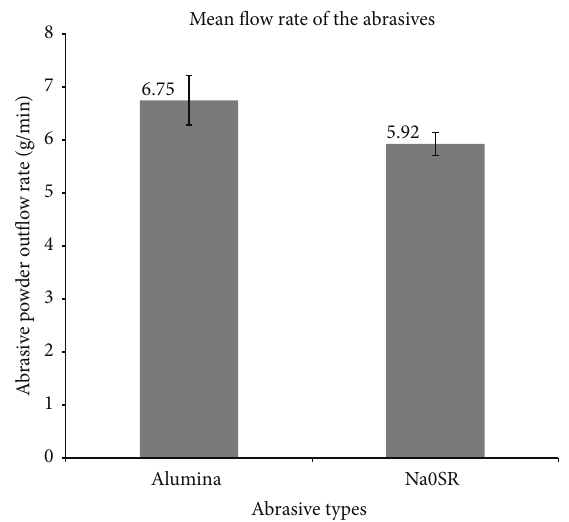
Figure 4: Comparison of mean flow rate between alumina and Na0SR abrasives.